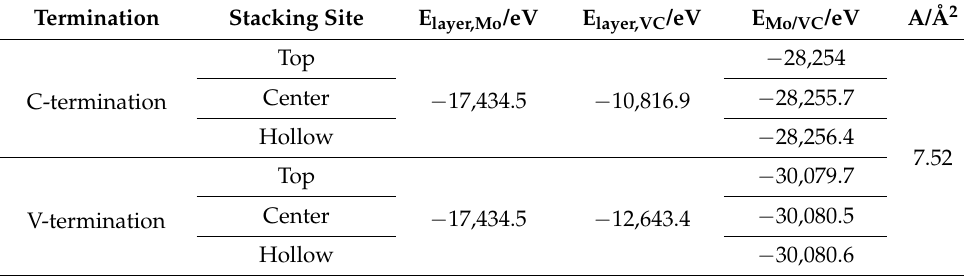
Table 4. Relevant data required for W ad calculation.